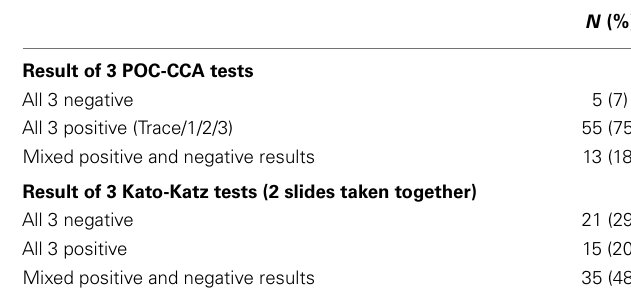
Table 2 | Consistency of results for three consecutive diagnostic tests for schistosomiasis on 73 school children, Kenya .